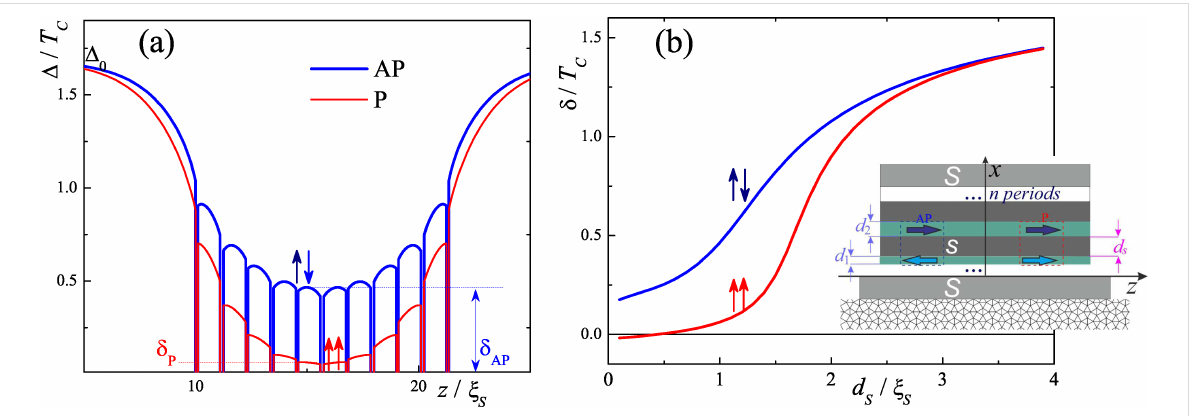
Figure 2: (a) The depth profile of the superconducting pair potential amplitude of the S/[F 1 /s/F 2 /s] 5 /F 1 /S structure in the P and AP cases. (b) The amplitudes of the superconducting pair potential in the middle of the weak link for the same situations. Inset – schematic representation of the consid- ered stack